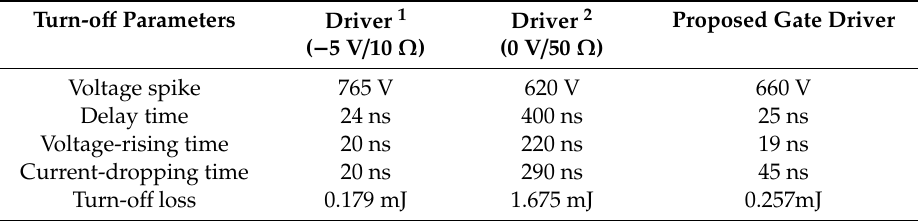
Table 7. Experimental results of turn-o ff process based on di ff erent gate drivers.